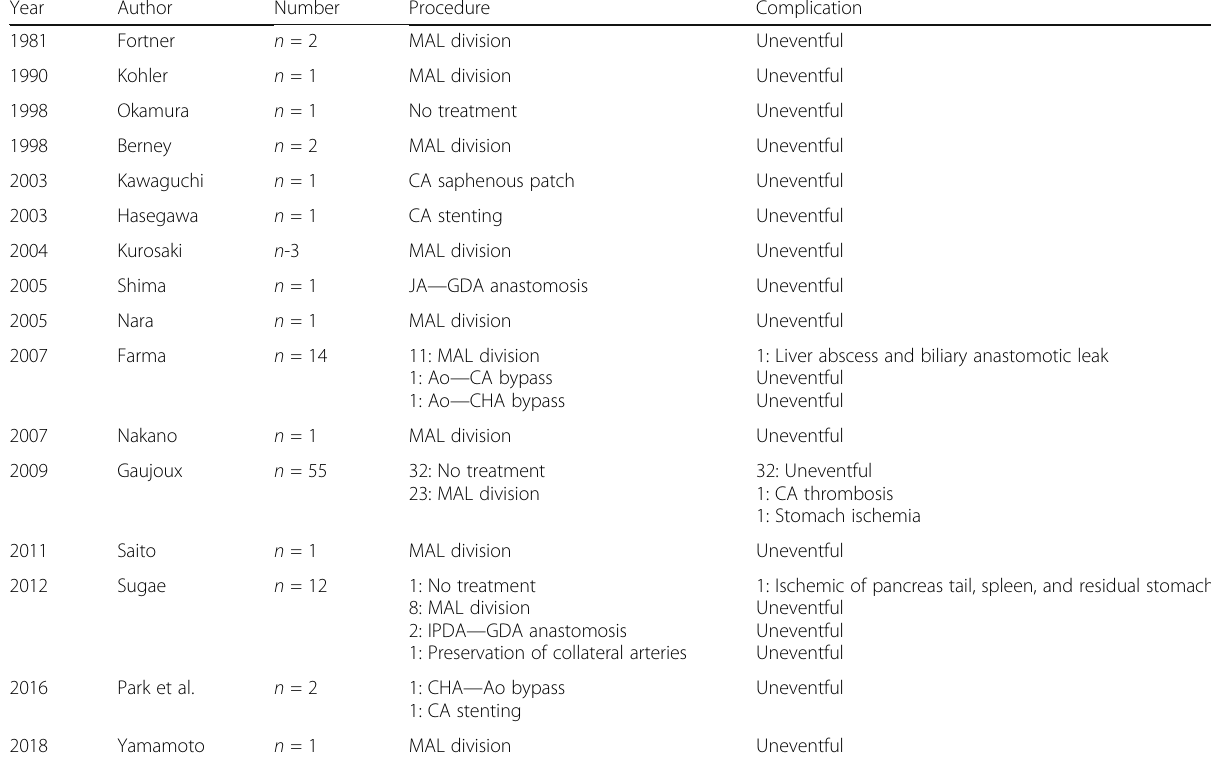
Table 2 Summary of CACS caused by MALS on previous